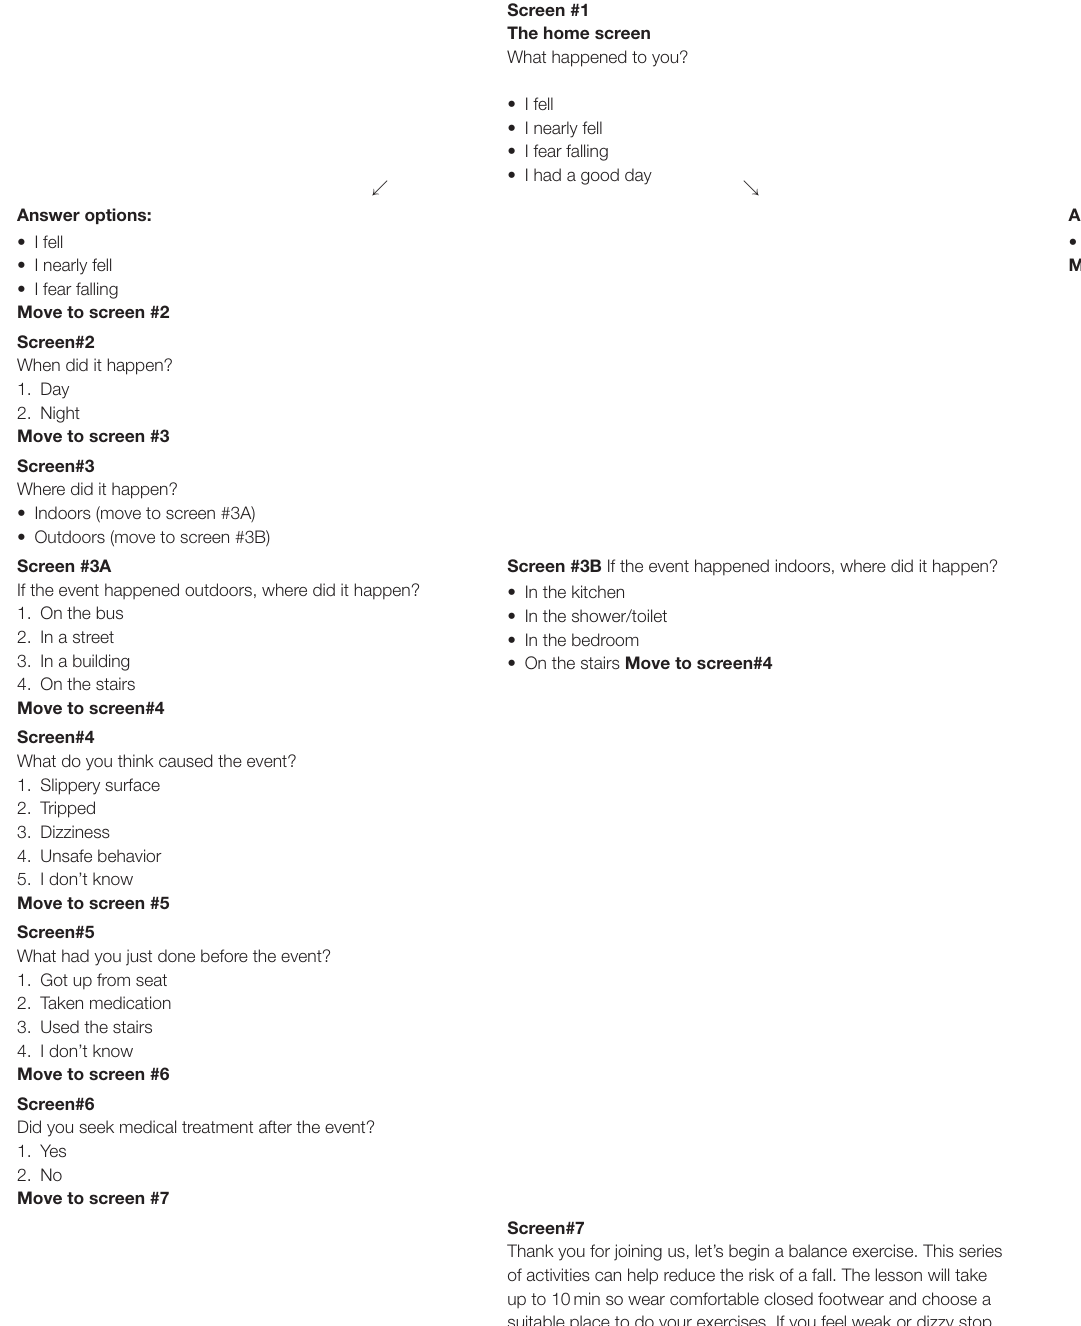
Screen #1 The home